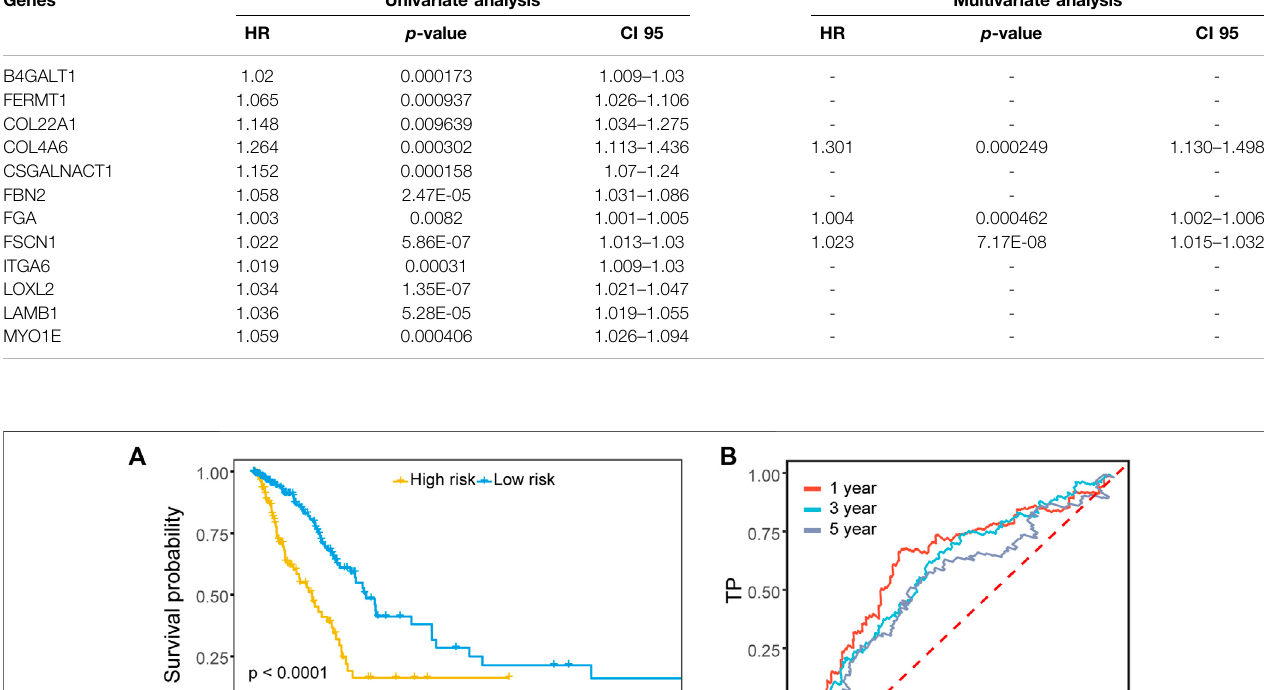
TABLE 1 | Univariate and multivariate Cox analysis of 12 prognosis related ECM organization genes. Genes